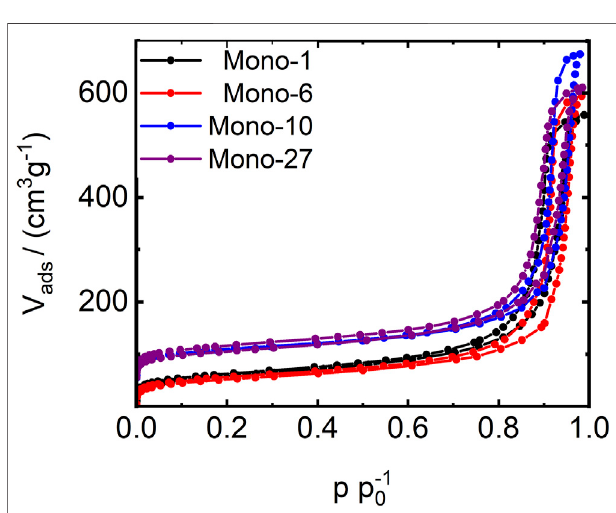
FIGURE 2 | Nitrogen physisorption isotherms for the HSM samples Mono-1 through